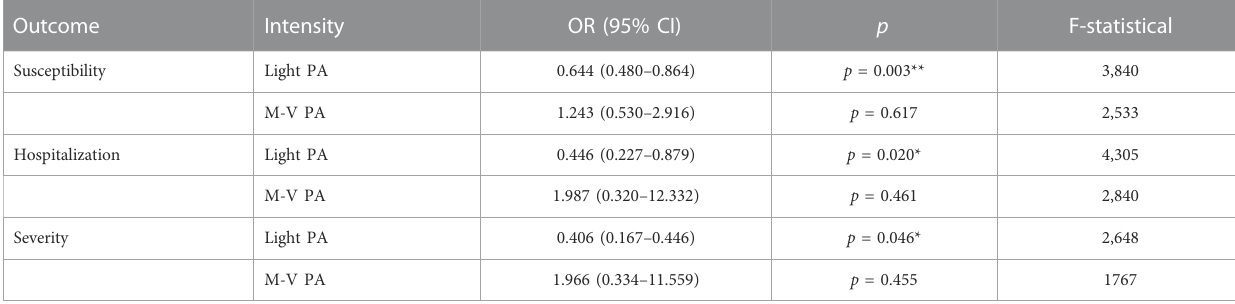
TABLE 1 Results of the IVW model and statistic power.